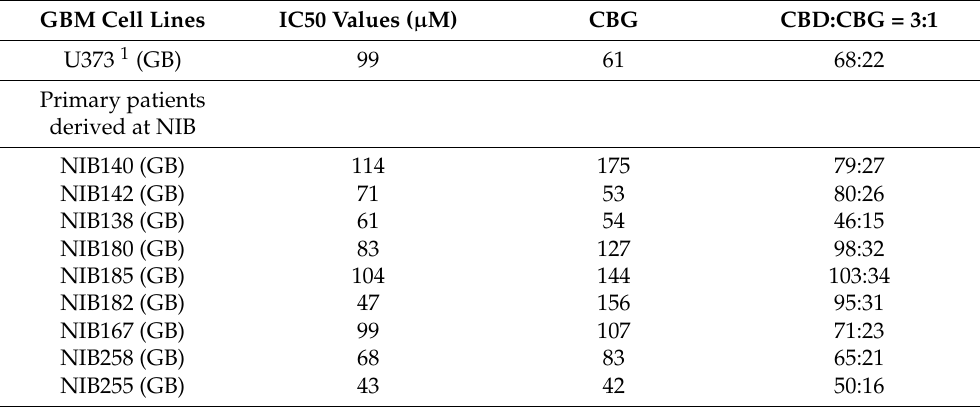
Table 2. Mean IC50 ( µ M) values for glioblastoma (GBM) differentiated and GBM stem cells (GSCs) for cannabidiol (CBD) and cannabigerol (CBG) treatment alone and at the molar ratio of 3:1. GBM Cell Lines IC50 Values ( µ